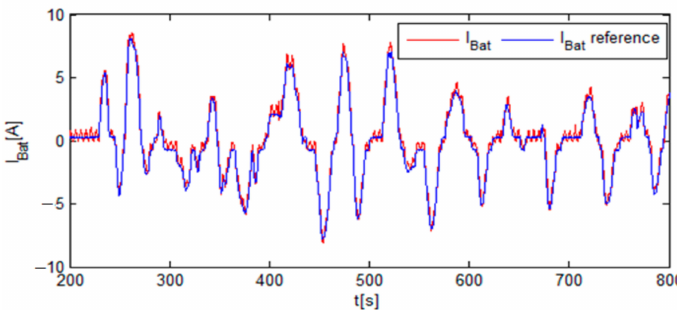
Figure 30. Zoom on the battery current control